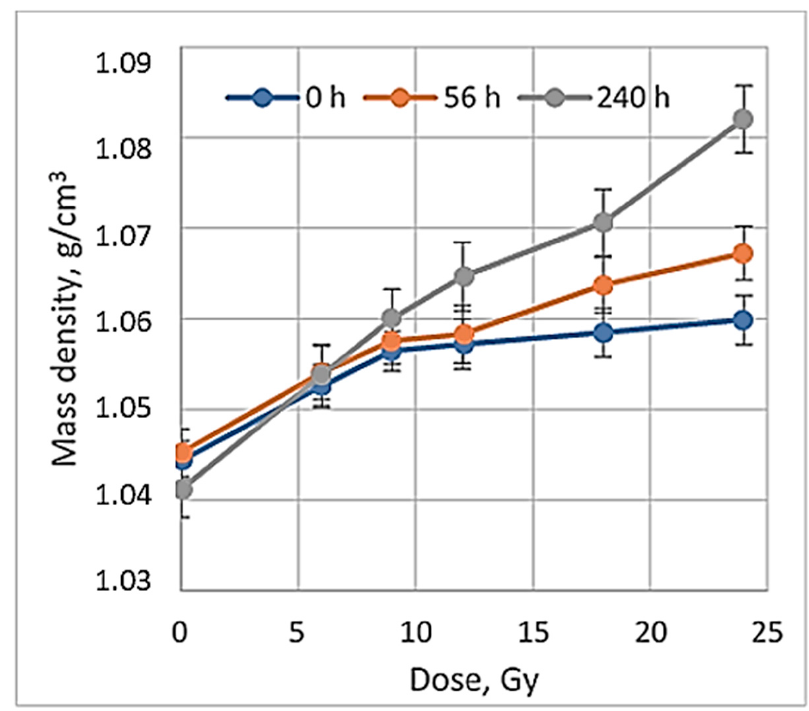
Figure 5. Post-irradiation time depending mass density changes in irradiated gels.